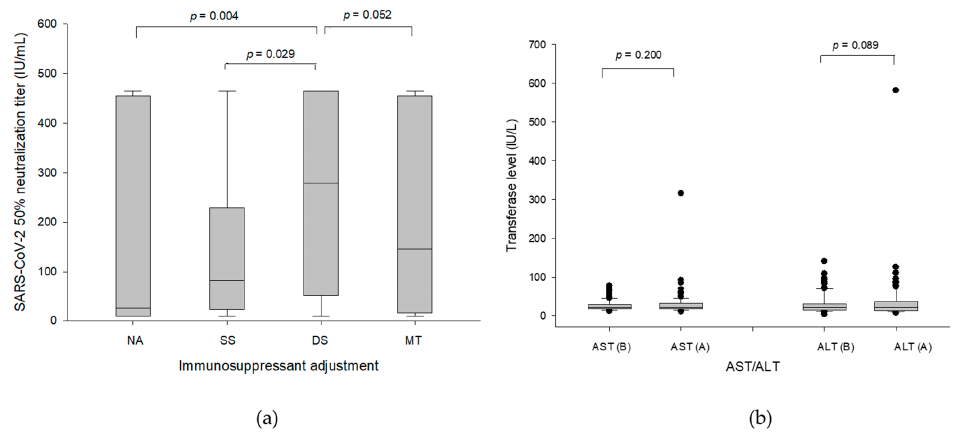
Figure 1. ( a ) The values of COVID-19 NT 50 in different groups of patients. The median (interquartile) antibody value of post-vaccination serum NT 50 were 279.3 (50.61–465.04) IU/mL in the DS group of patients, which was higher than 82.93 (22.63–229.37) IU/mL in SS group of patients ( p = 0.029) and 25.09 (9.62–455.27) IU/mL in NA group patients ( p = 0.004), and also had a tendency higher than 145.61 (15.02–455.27) IU/mL in MT group patients ( p = 0.052). ( b ) The liver function tests before and after the vaccinations in DS group patients. The median (interquartile, range) of AST was 20 (16– 30.8, 9–316) U/L after vaccinations compared to 19.5 (16–27.8, 10–78) before vaccinations ( p = 0.200). The median (interquartile, range) of ALT was 20.5 (12–34.8, 6–581) U/L after vaccinations compared to 19.5 (13–30, 2–141) before vaccinations ( p = 0.089). (B, before vaccination; A, after vaccination).